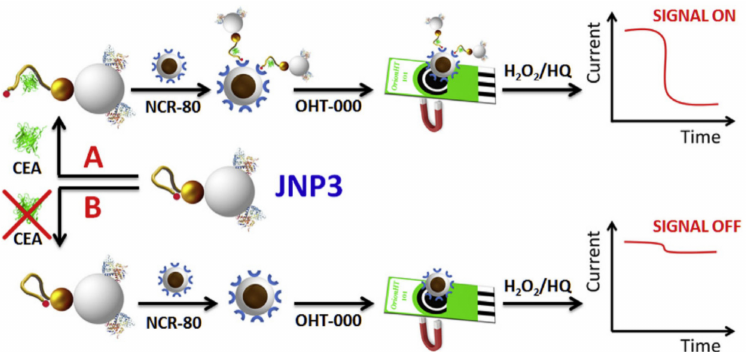
Figure 10. Schematic display of the Janus nanoparticles-based biosensing strategy for CEA detection. Reprinted with permission from ref. [157]. Copyright © 2019 Elsevier